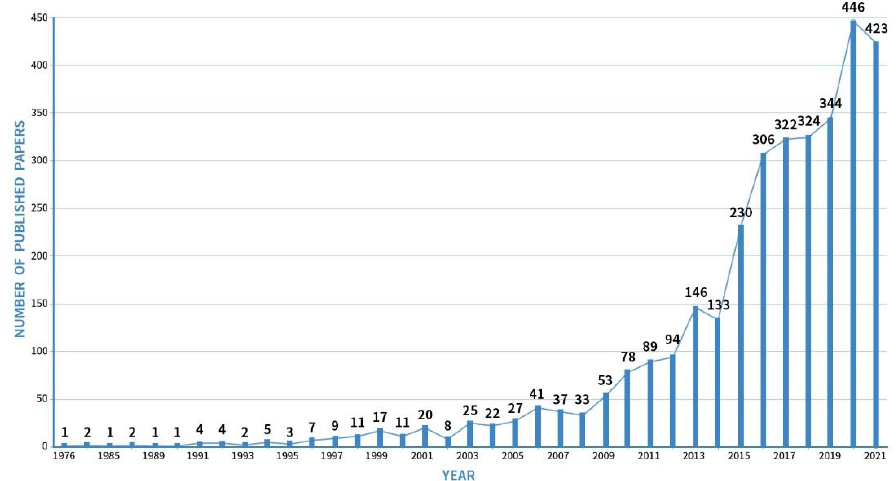
Figure 1. The annual number of soundscape studies published from 1976 to 2021.